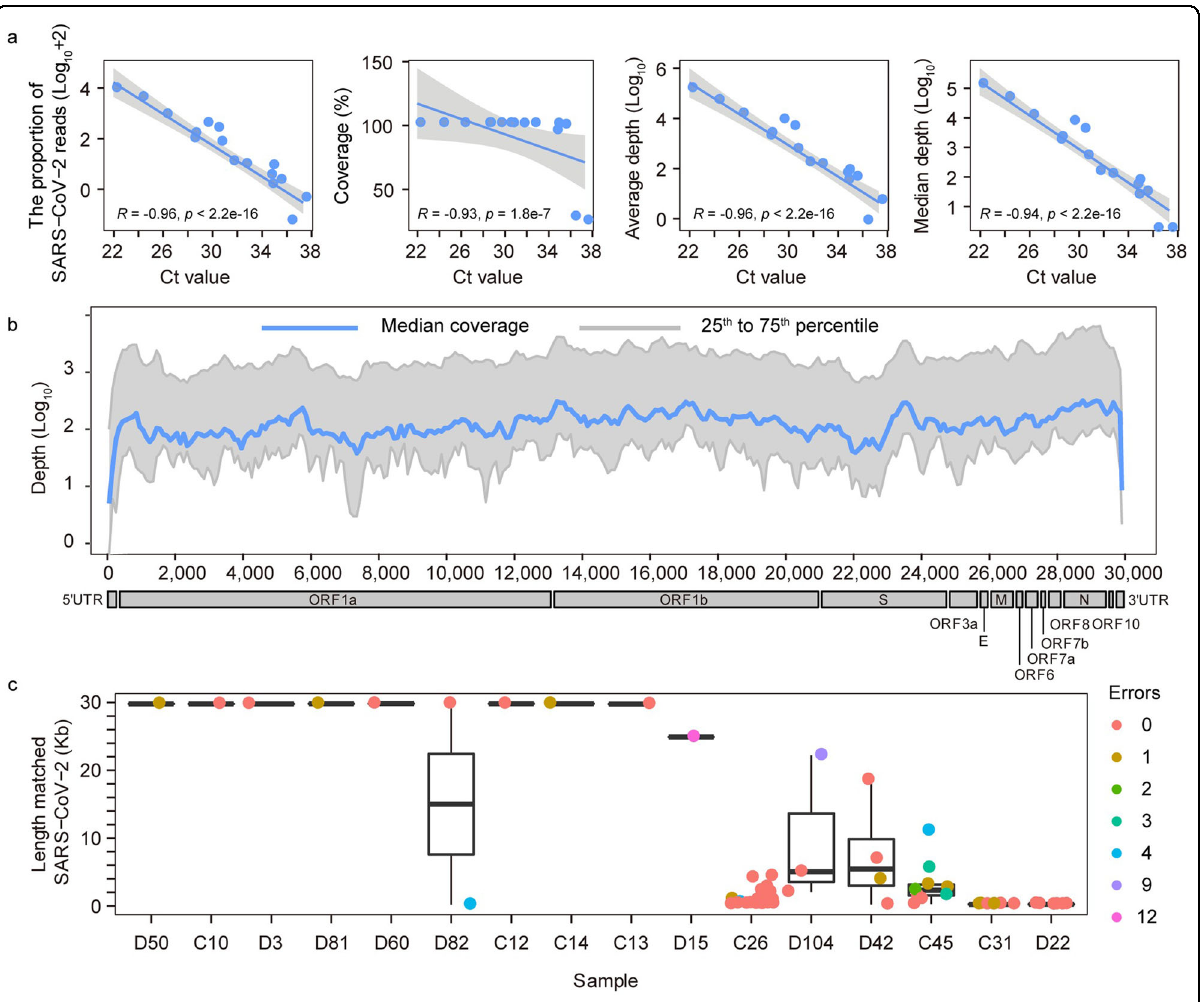
Fig. 2 Genome coverage of SARS-CoV-2. a Correlation between SARS-CoV-2 sequencing data and Ct values. From the left to the right: the correlation between the ratio of SARS-CoV-2 reads, the coverage of SARS-CoV-2 genome, the average sequencing depth, the median sequencing depth, and the Ct value of each sample. Linear regression indicates the relationship between the sequencing data and the Ct value of samples. b Genome coverage of sequenced samples across the SARS-CoV-2 genome. The x -axis represents the viral genome position, the y -axis represents the log 10 depth of each site. Lines in blue represent the median sequencing depth, and areas in gray represent 25th to 75th percentile of sequencing depth. c De novo assembly results of SARS-CoV-2. The x- axis represents each sample, and the y -axis represents log 10 lengths of contigs matching SARS-CoV-2. Boxplots represent the length distribution of contigs matching SARS-CoV-2. Dots in different colors represent the number of error bases (shown in legends) in each contig relative to previously known genome